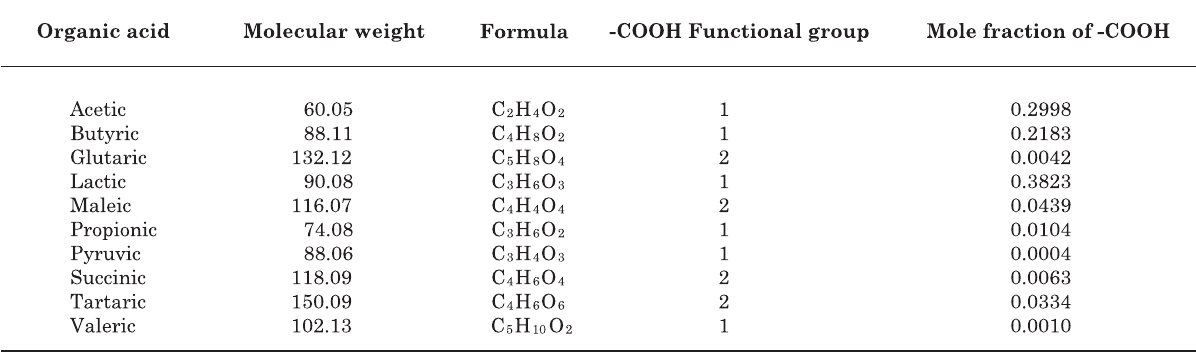
(1) Adapted from Koo et al. (2006,